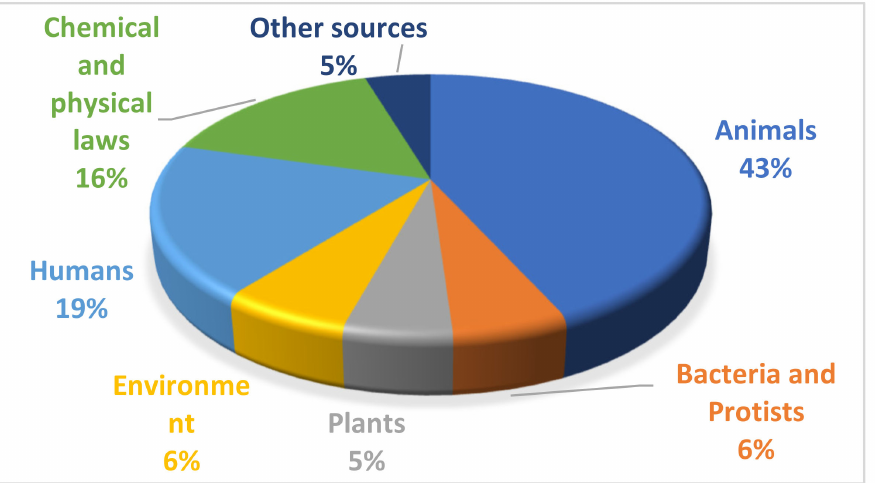
Figure 1. Distribution of newly proposed algorithms in the period 2006–2021, based on their inspira- tion